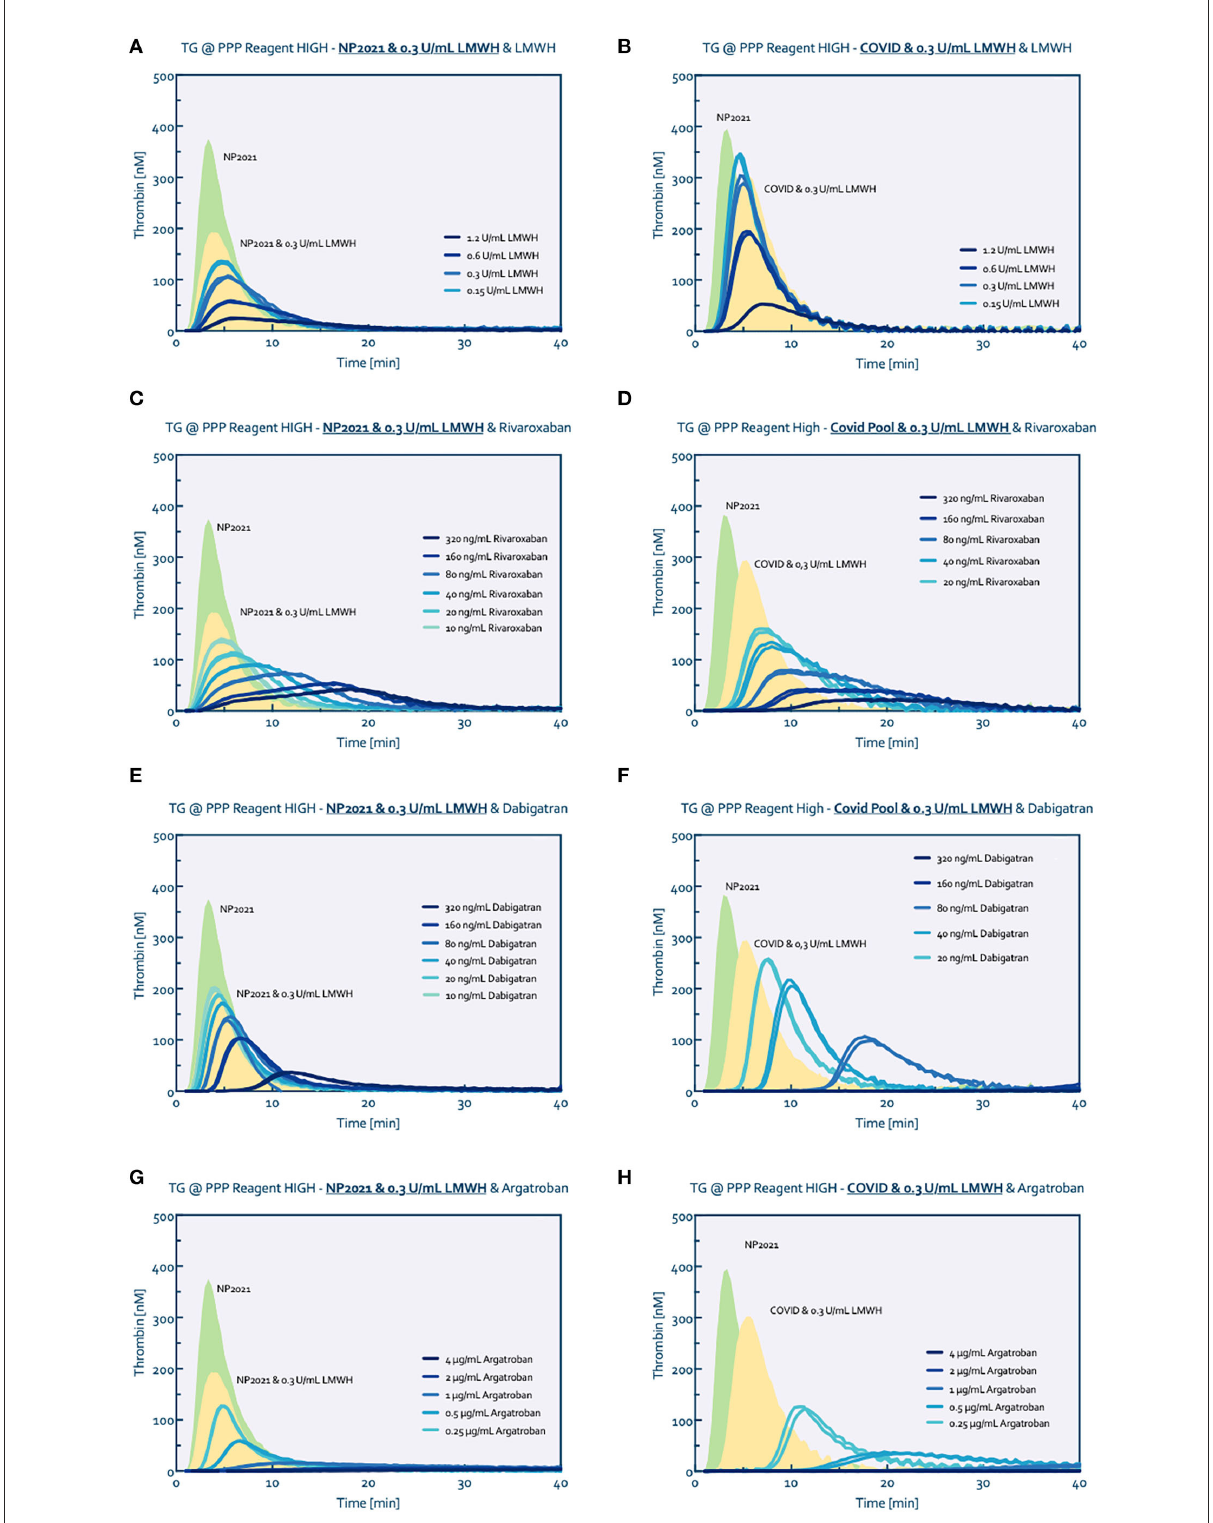
FIGURE2 Thrombin generation titrated with several anticoagulants. Normal pool plasma (NP) was measured without (green curve) and with the addition of 0.3 U/mL LMWH (yellow curve) to match the baseline conditions of the COVID pool plasma (0.3 U/ml LMWH). Thrombin generation was consecutively measured after spiking with LWMH (A,B) , Rivaroxaban (C,D) , Dabigatran (E,F) and Argatroban (G,H) ,